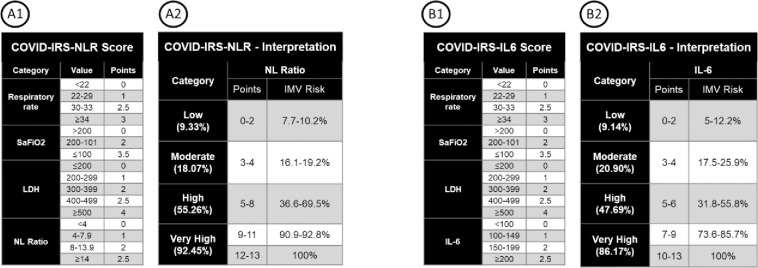
COVID-IRS-NLR and COVID-IRS-IL6 scoring and interpretation.Here we show the algorithm for calculating both COVID-IRS-NLR (A1 and A2) and COVID-IRS-IL6 (B1 and B2) scores. Scores are assigned using the cut points in either the A1 or B1 panel, and the resulting sum is interpreted in the corresponding A2 or B2 panel, which in turn dictates the risk strata for IMV.